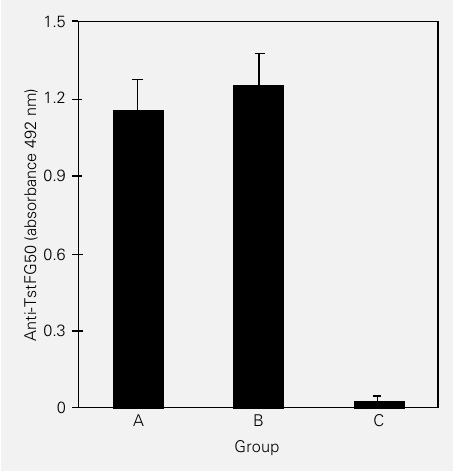
Figure 1 - Anti-TstFG50 reactivity of sera of CF1 mice immu- nized with liposomes. Group A (N = 15) mice received the TstFG50 liposomes, group B (N = 15) received trypsin- treated TstFG50 liposomes and group C (N = 15)